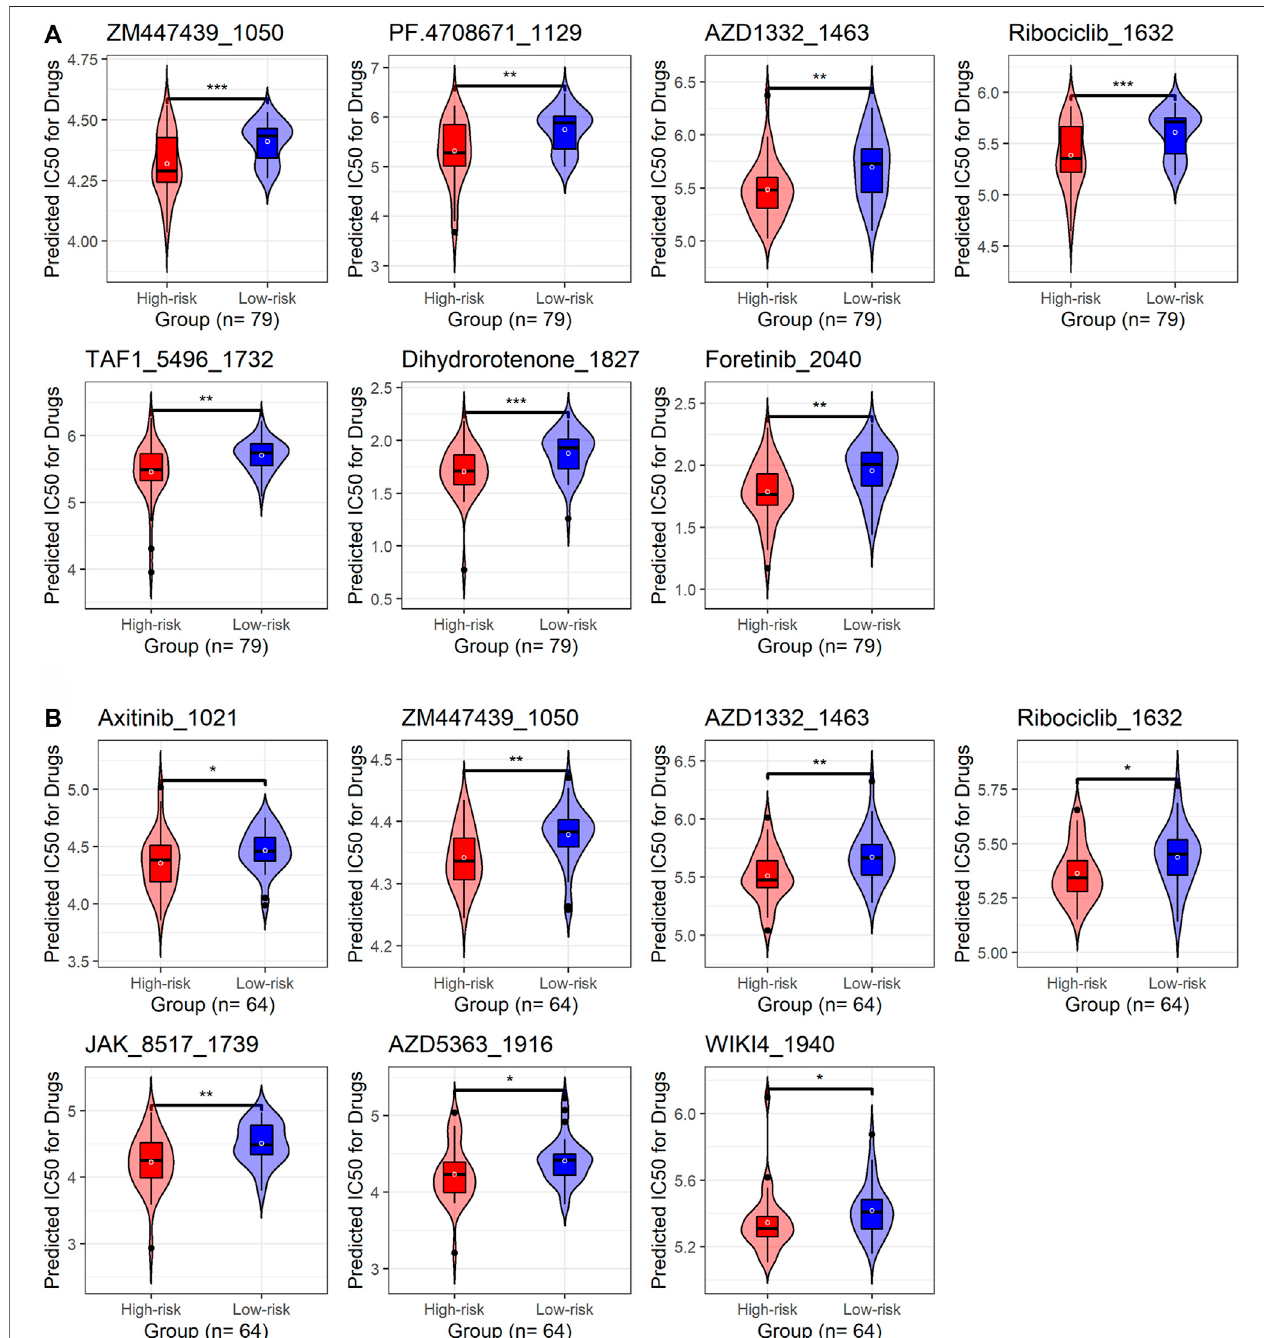
FIGURE10| Theunderlyingtargetdrugsform7GPSbasedonhalf-limitingdosevalues. (A) Discoverycohort. (B) Externalvalidationcohort.Thehigh-riskandlow- risk groups areclassi fi edbased onthe median risk scoreofthe cohort; p -values werecalculated based on Wilcoxon rank-sum tests; * p < 0.05; ** p < 0.02; *** p < 0.001.